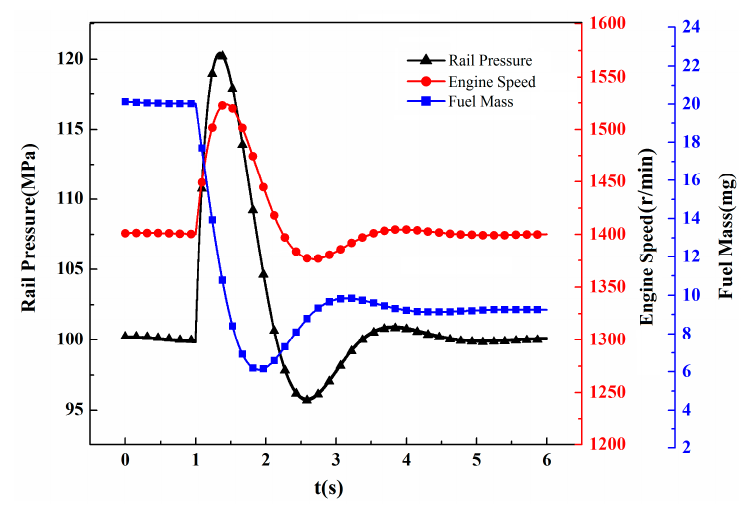
Figure 15. Rail pressure, engine speed and fuel mass vs. time controlled by LQR.